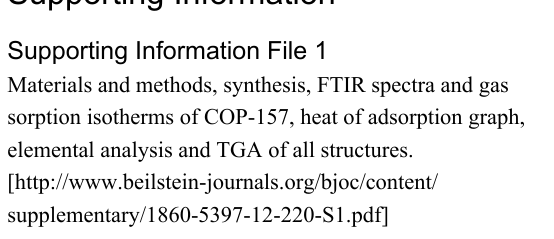
In summary, we have shown that highly porous cyanovinylene networks could be obtained through Knoevenagel condensation of benzylic nitriles and aldehydes by choosing appropriate building blocks. The resulting nitrile functionalities in COP-156 could be easily modified into free amine or amidoxime groups. The amine functionalities in COP-156-amine allowed for higher CO 2 binding strength and therefore led to fast and improved CO 2 uptake in moist